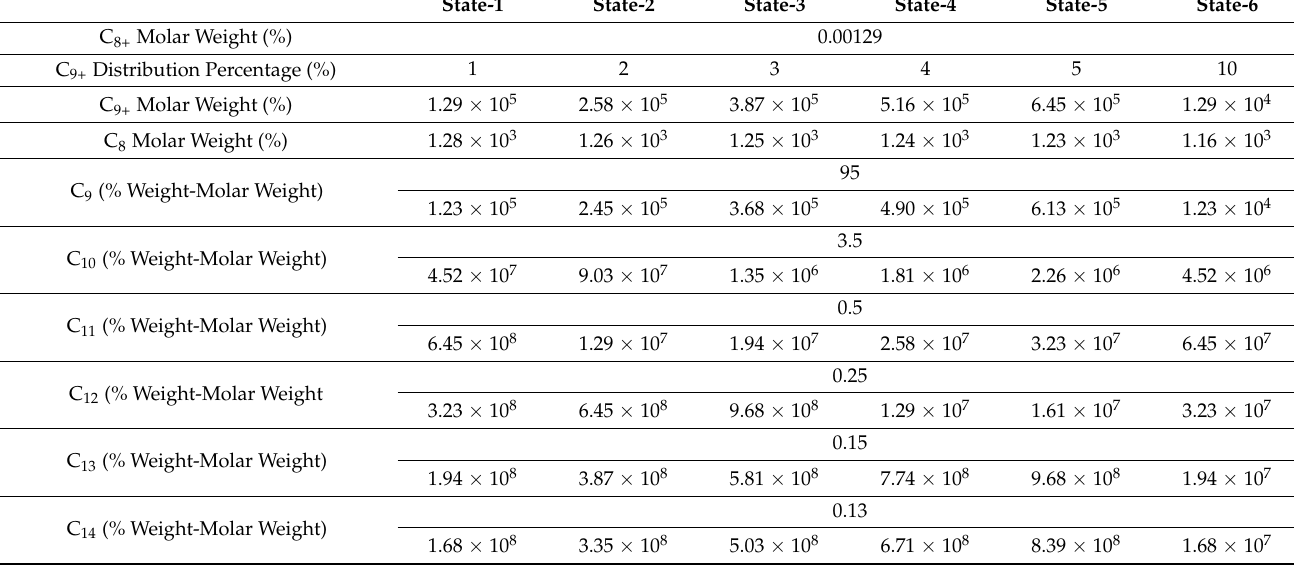
Table A1. C 9 –C 19 data analysis of Pendik RM-A